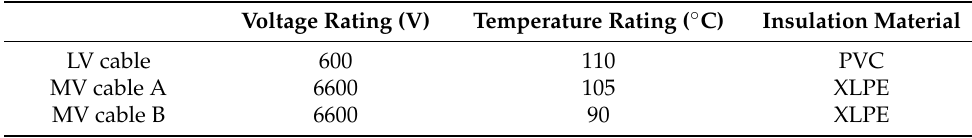
Table 1. Electric cable samples used in this